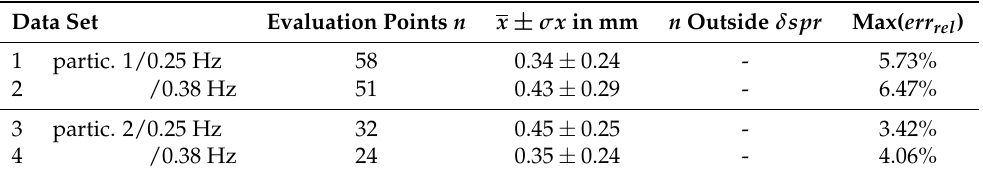
Table 3. Summarized results of unloaded knee bends